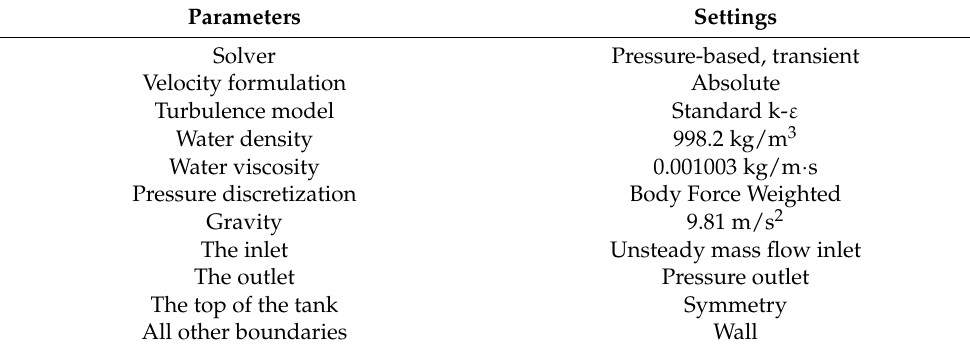
Table 1. Summary of the boundary conditions and the solver parameters of the CFD